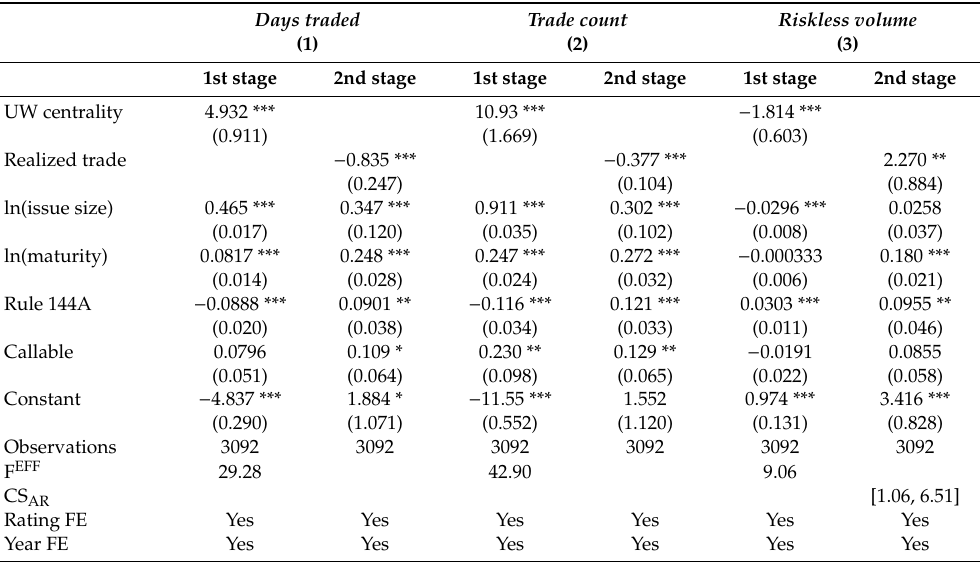
Table 7. IV Regressions for O ff ering Yield Spread: Bonds rated BBB + and